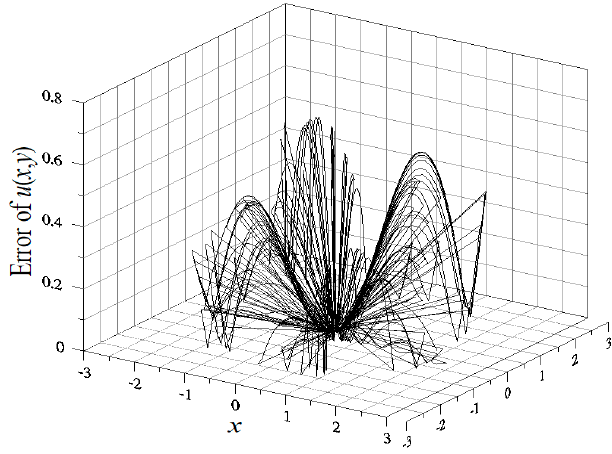
Figure 17. The numerical errors of the proposed method solution for the steady-state AC equation with the gear shaped irregular domain.